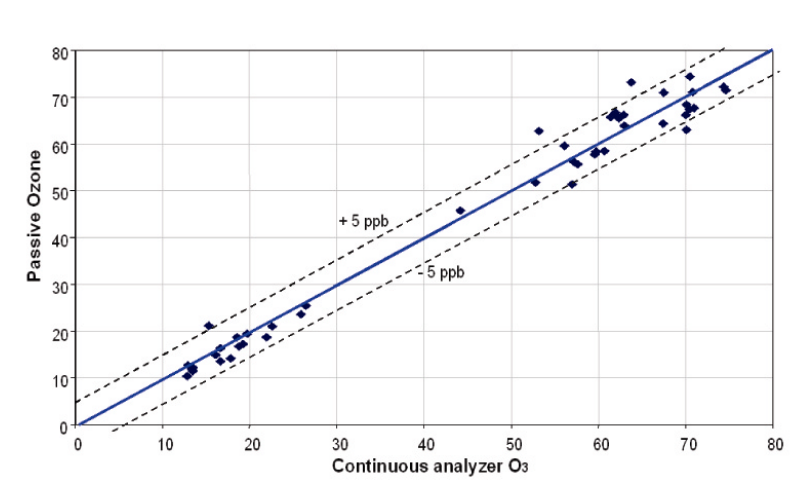
FIGURE 3. Comparison of the passive ozone to collocated EPA-certified continuous ozone monitors operated according to EPA guidelines and calibrated with transfer standards. The solid line shows the 1:1 relationship to assist in visual